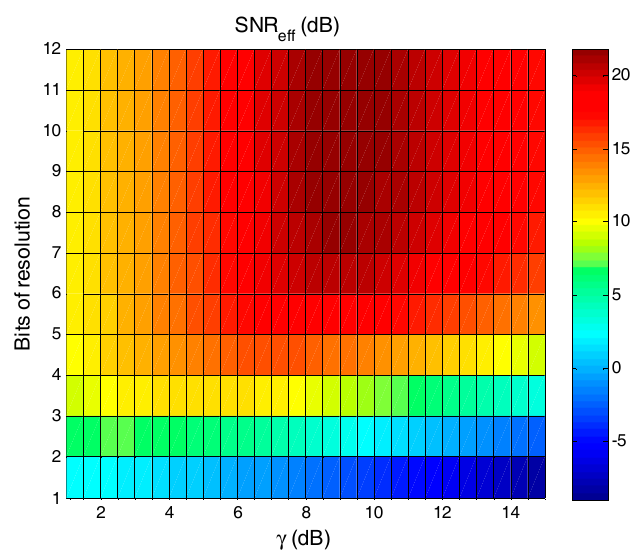
Figure 1. Distribution of the effective signal-to-noise ratio (SNR) for different clipping ratio and bits resolution.